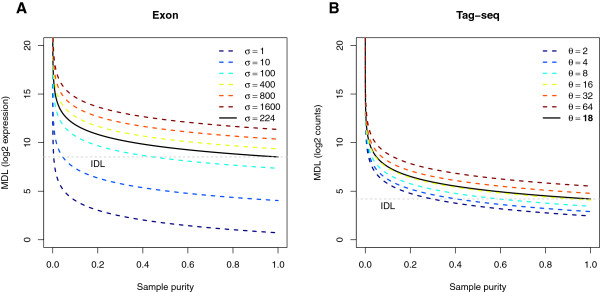
MDL of exon microarray and tag-seq. MDL plotted as a function of sample purity by (A) exon microarray and (B) tag-seq. Full drawn black line is the MDL estimate from the experiment. Dotted lines show MDL for a range of standard errors (exon) and dispersion parameters (tag-seq). IDL is the instrument detection limit defined as 367 when 95% confidence was used for exon microarrays and 18 for tag-seq when the linear mean-variance negative binomial regression was used. In the pure sample detection of signal is not possible below the IDL.